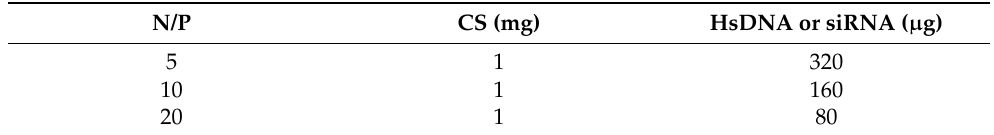
Table 1. Weight ratios ( w / w ) between CS and nucleic acid used to synthetize polymeric particles with different N/P